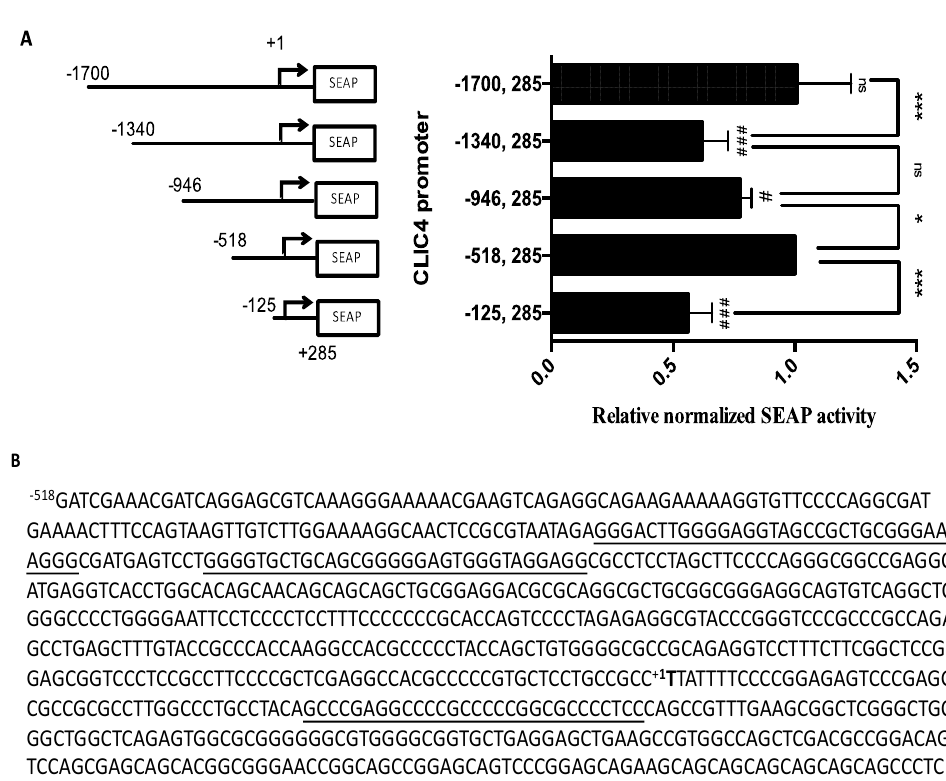
Figure 1. ( A ) A series of truncated CLIC4 promoter regions were constructed in the pSEAP2-Basic vector, and the relative activities of the CLIC4 promoter were compared to p( − 518, +285). After transfection in A375 cells for 48 h, media were collected and a secreted embryonic alkaline phosphatase (SEAP) assay was performed. +1 indicates the transcription start site (TSS). Data are expressed as the means ± SD of three replicates. # p < 0.05, ### p < 0.001, as compared to p( − 518, +285). * p < 0.05, *** p < 0.001 as compared to the adjacent promoter region. ns: non-significant difference; ( B ) Sequence of the CLIC4 promoter ( − 518, +285). The underlined sequences are potential G-quadruplexes (PG4s).